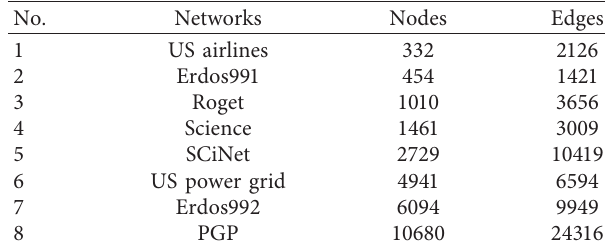
Figure 2: Performance in NMI of the six algorithms with different network sizes N . The network sizes are 324, 736, 1654, 3102, 6458, and 14987, respectively. In (a), the six algorithms are evaluated with μ � 0.3. Already in (b) μ is set to 0.35. Table 2: The hyperparameters of the LFR